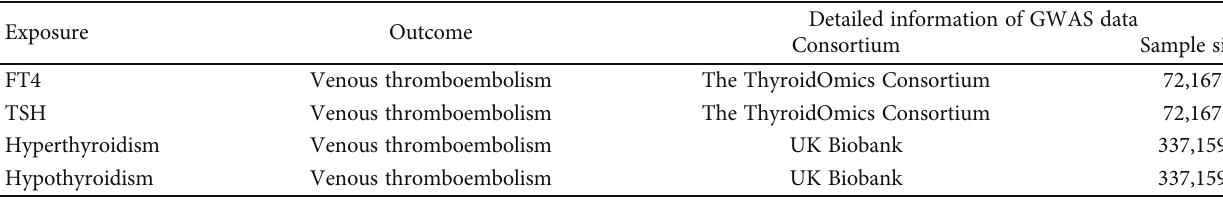
Table 1: The detailed information of GWAS data included in Mendelian randomization analysis.